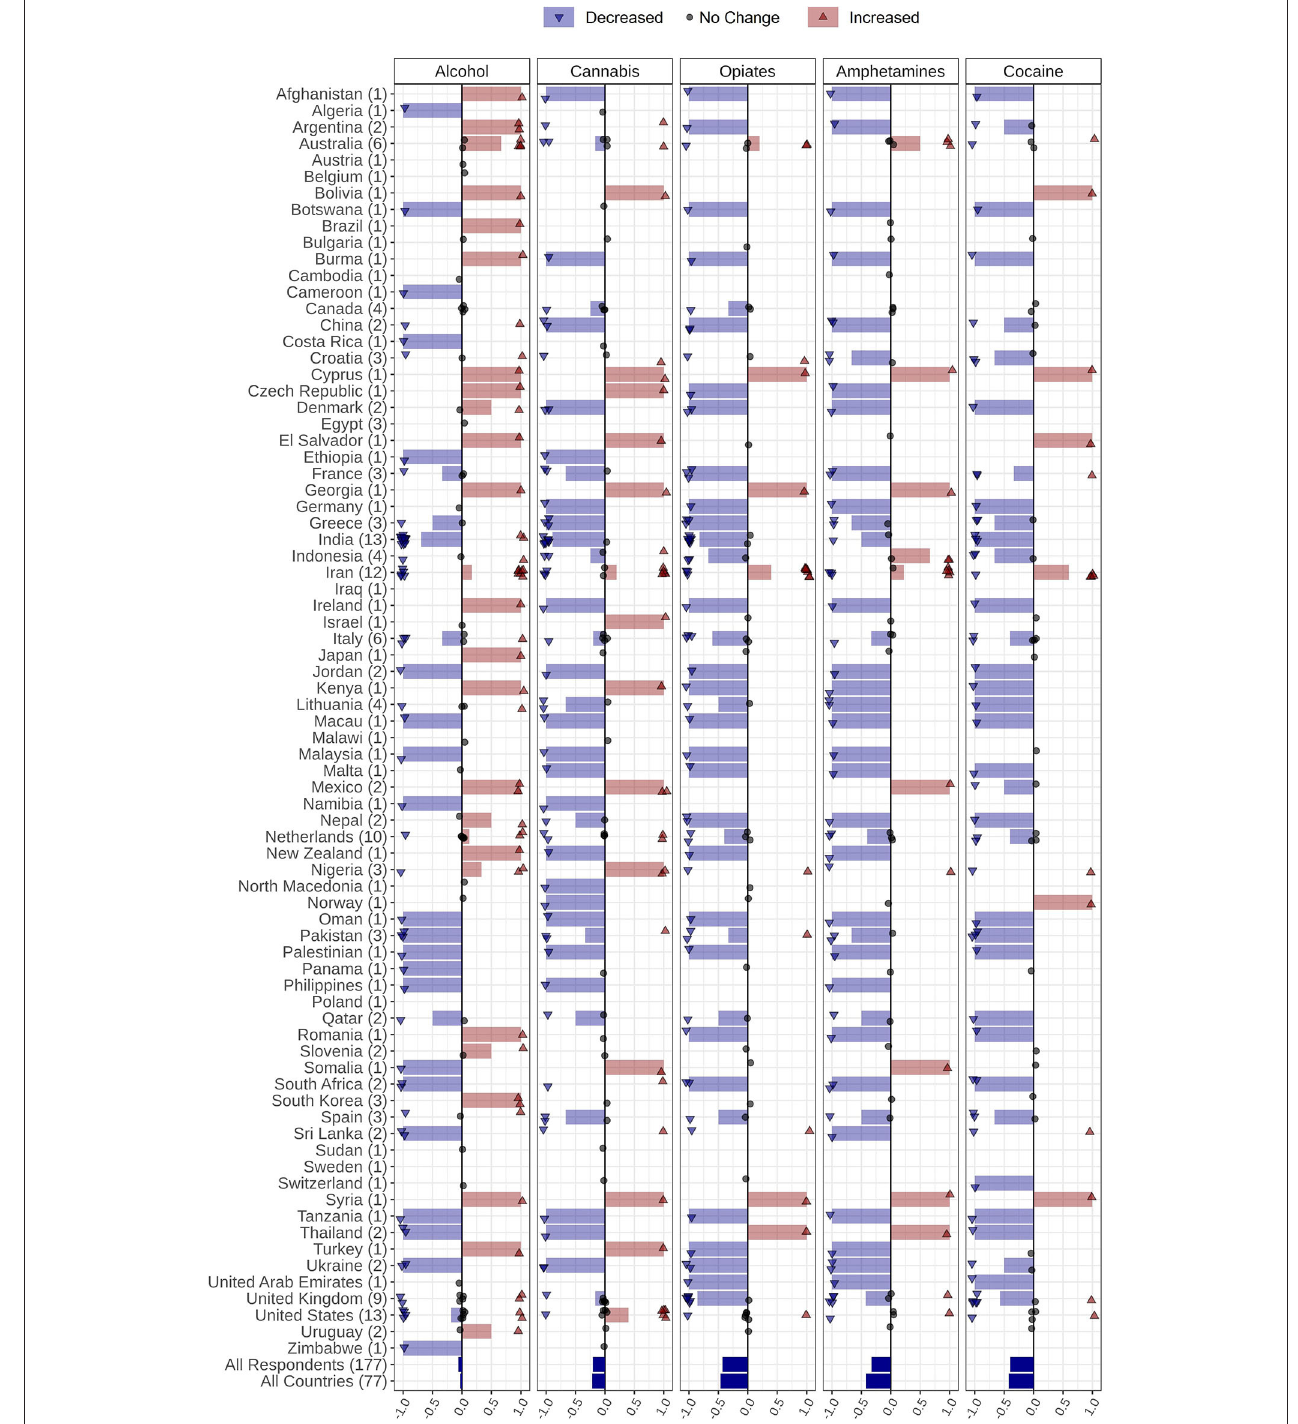
FIGURE 3 | Changes in alcohol and drug supply during the COVID-19 pandemic reported by 177 respondents from 77 countries globally. Respondents were asked to report changes the supply of alcohol, amphetamines, cannabis, cocaine, and opiates through the following options: Increased supply, decreased supply, no change, and I do not know. Countries’ names are sorted in alphabetical order, and the number of respondents from each country is in parentheses following the country name. Each response is indicated as a single dot for no change or up and down triangles for increased and decreased answers, respectively, with a minor jitter for better visualization. The reported answers are represented as − 1 for decreased , 1 for increased , and 0 for no change; I do not know answers are not shown. The mean of all responses, regardless of their originated countries and without considering those who did not know the answer, alongside the average answers of all countries, regardless of the number of respondents in each country, are addressed in the last two rows below the countries’ names.